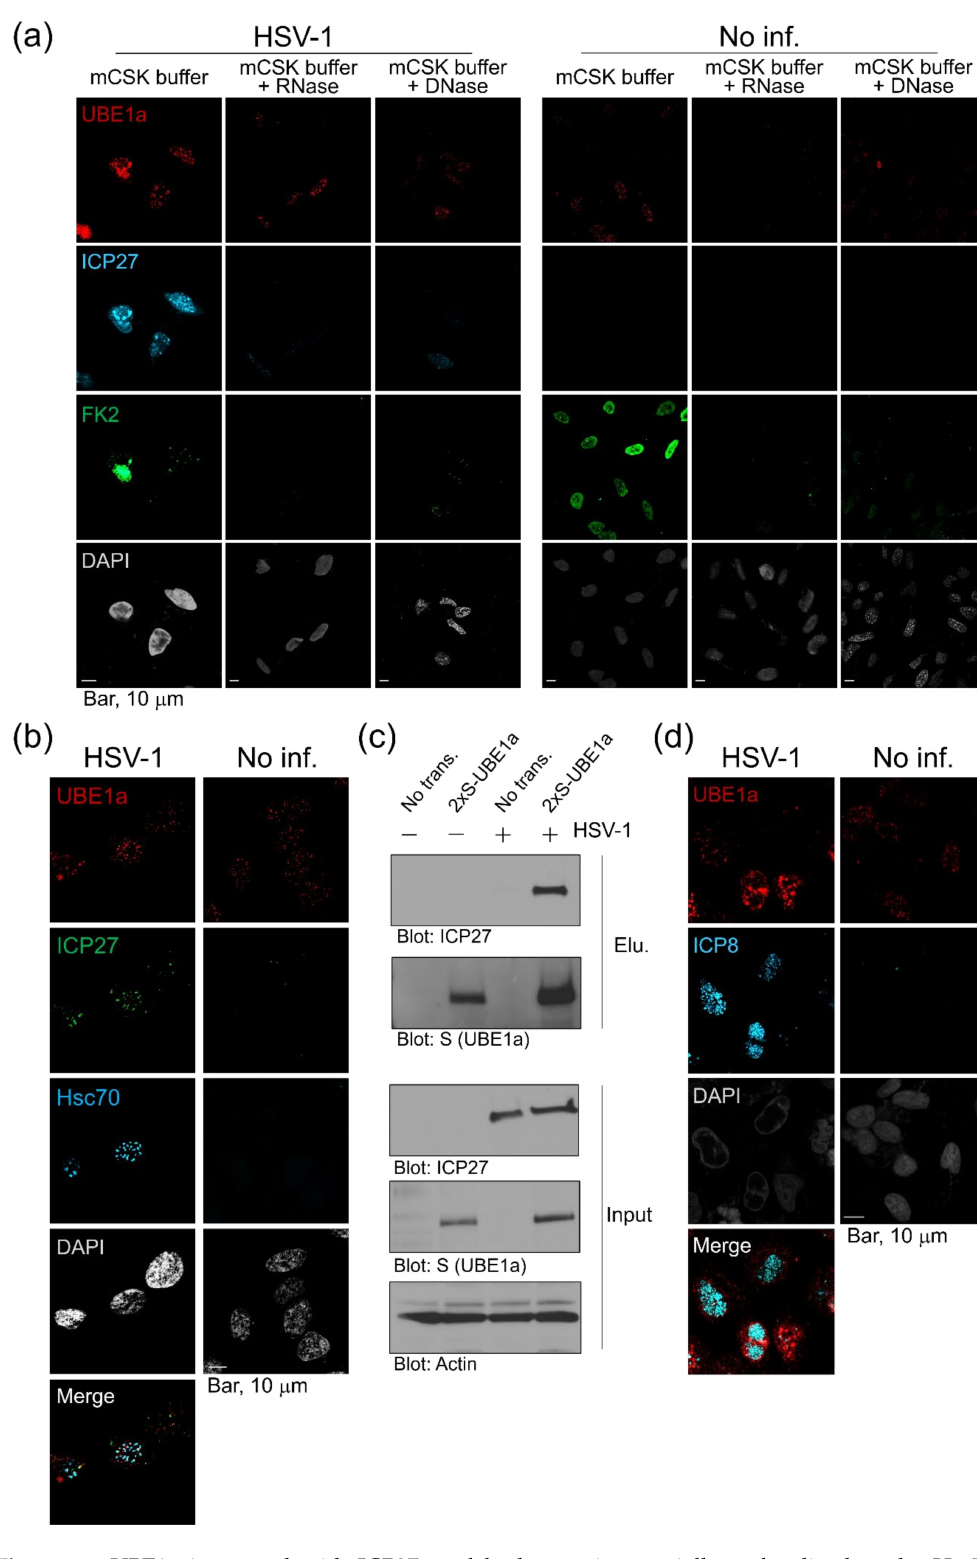
Figure 6. UBE1a interacted with ICP27, and both proteins partially co-localized at the Hsc70 foci / virus-induced chaperone-enriched (VICE) domains. ( a ) UBE1a, ICP27, and Ub-conjugates partially co-localized via DNA and RNA. HSV-1-infected HeLa cells were cultured for 18 h and were